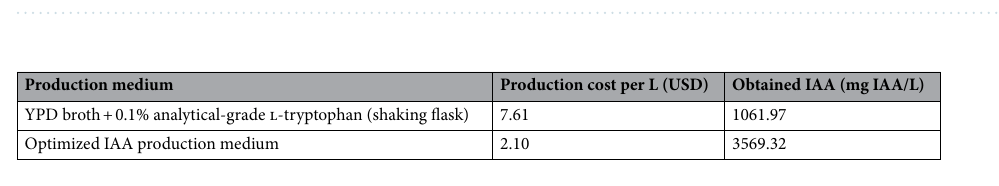
Table 2. Cost of IAA production medium in 100 L